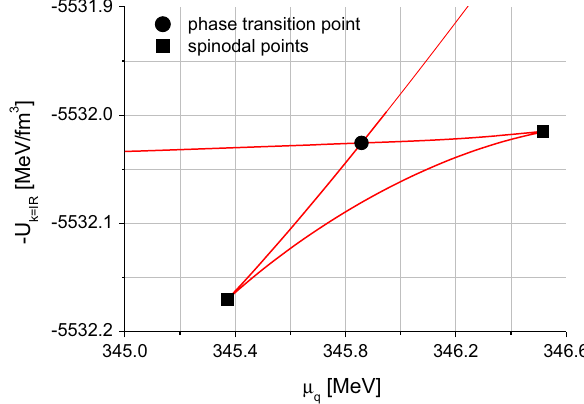
Fig. 1 Extrema of the infrared effective potential as a function of the quark chemical potential for T = 20MeV. The phase transition point is represented by the dot while the squares are the spinodal points